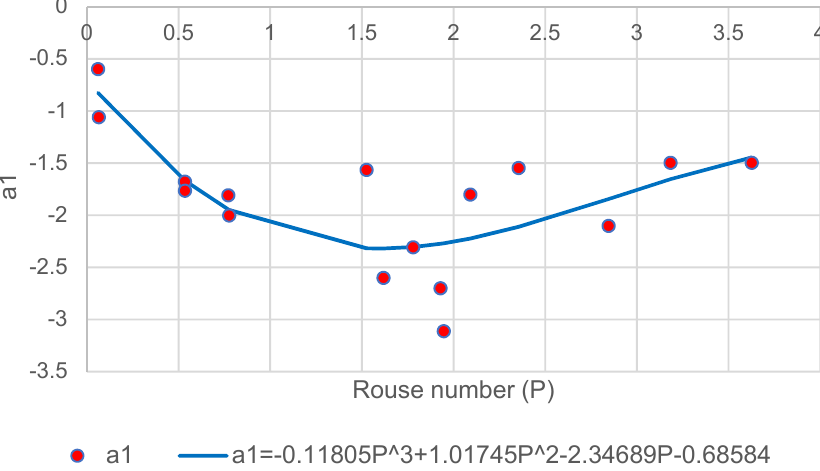
Figure 6. Rouse number vs. coefficient 𝑎 (cid:2869) using KNN ( 𝑅 (cid:2870) = 0.61 ).